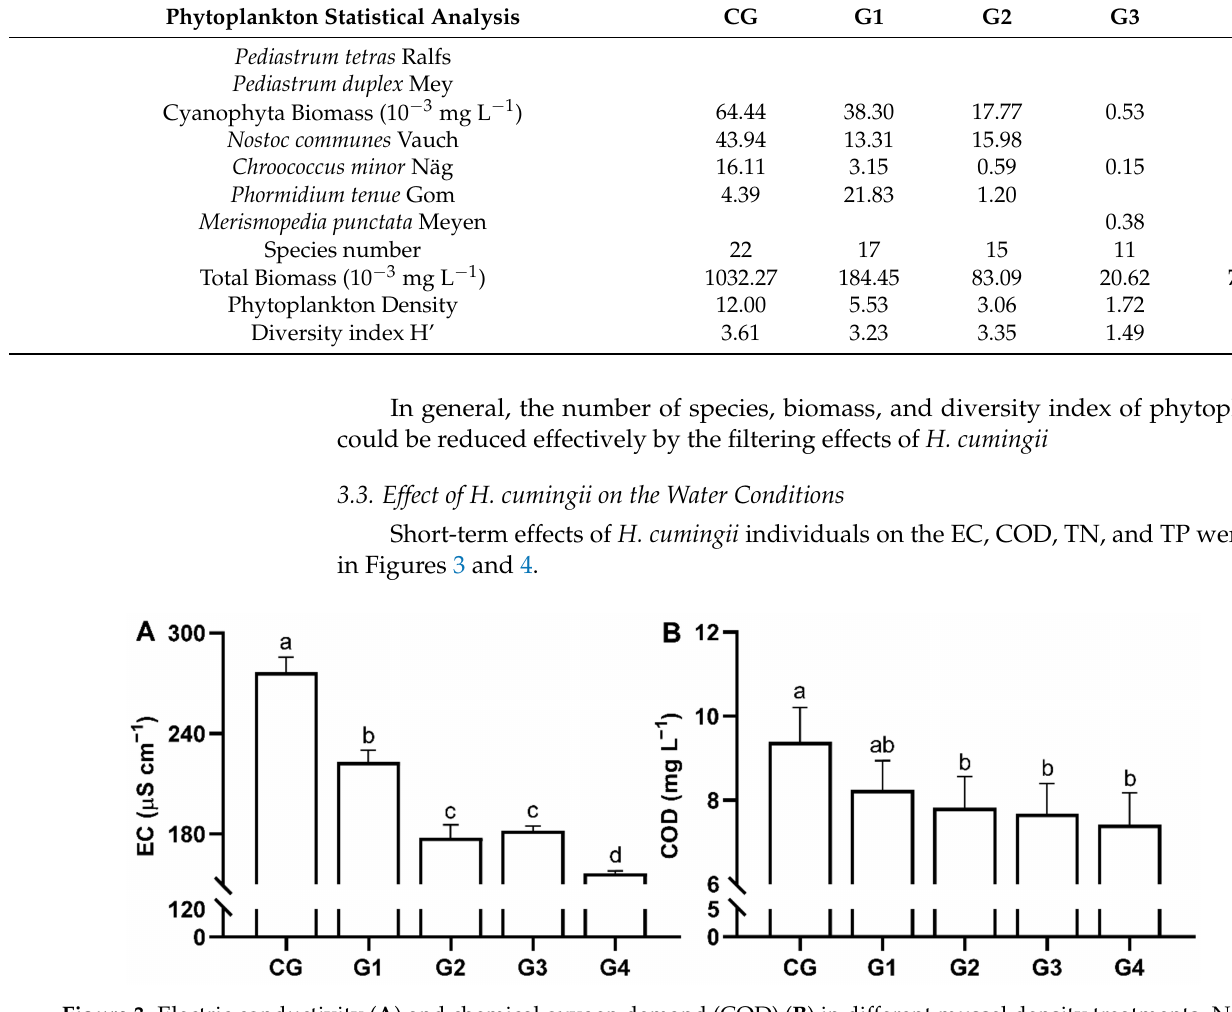
Figure 3. Electric conductivity ( A ) and chemical oxygen demand (COD) ( B ) in different mussel density treatments. Note: CG, G1, G2, G3 and G4 represent 0 mussels, 3 mussels, 6 mussels, 9 mussels and 6 mussels, respectively. Different lowercase letters denote significant difference between different treatments ( p < 0.05).